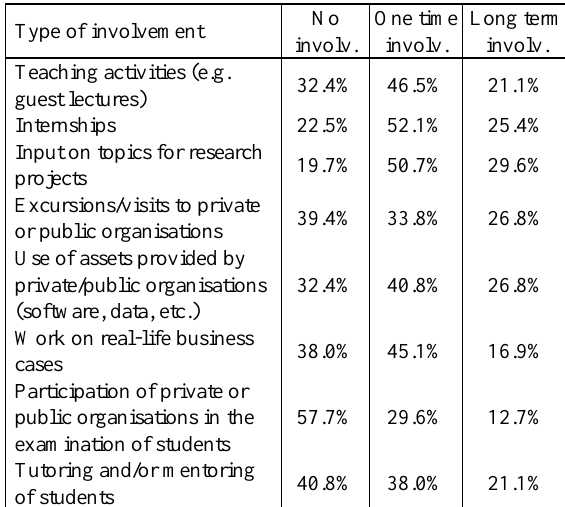
Table 1. Involvement of private/public sector in